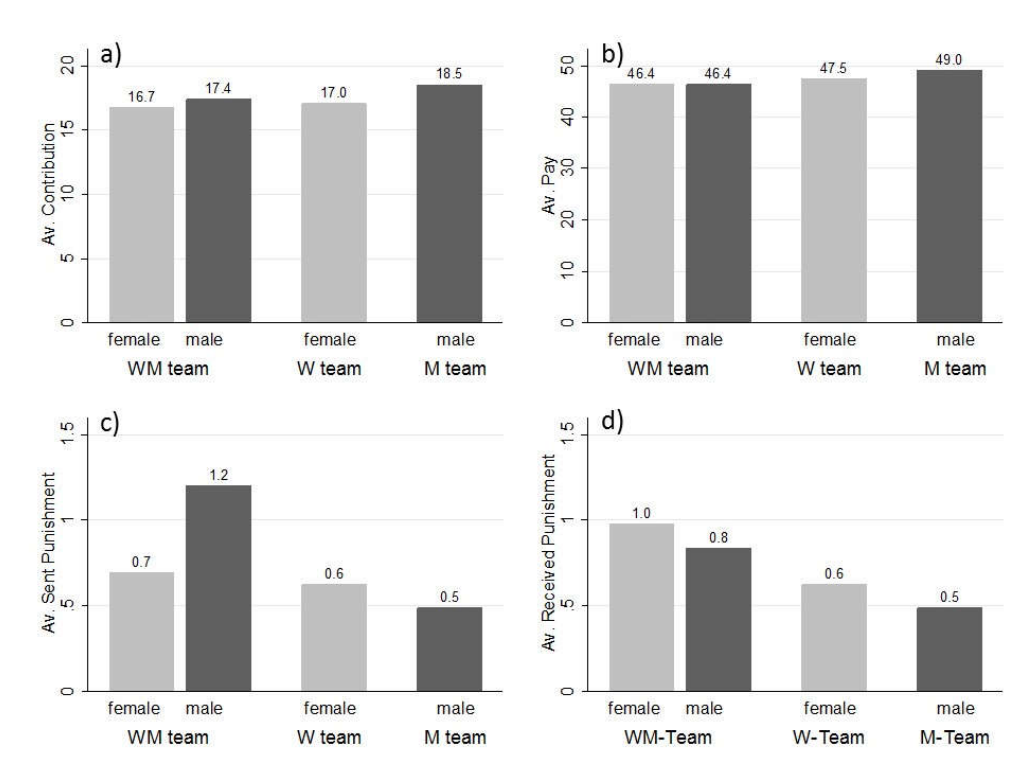
Figure A1. Average ( a ) contributions; ( b ) average pay; ( c ) average sent punishment points; and ( d ) average received punishment points; over all periods and teams, respectively.